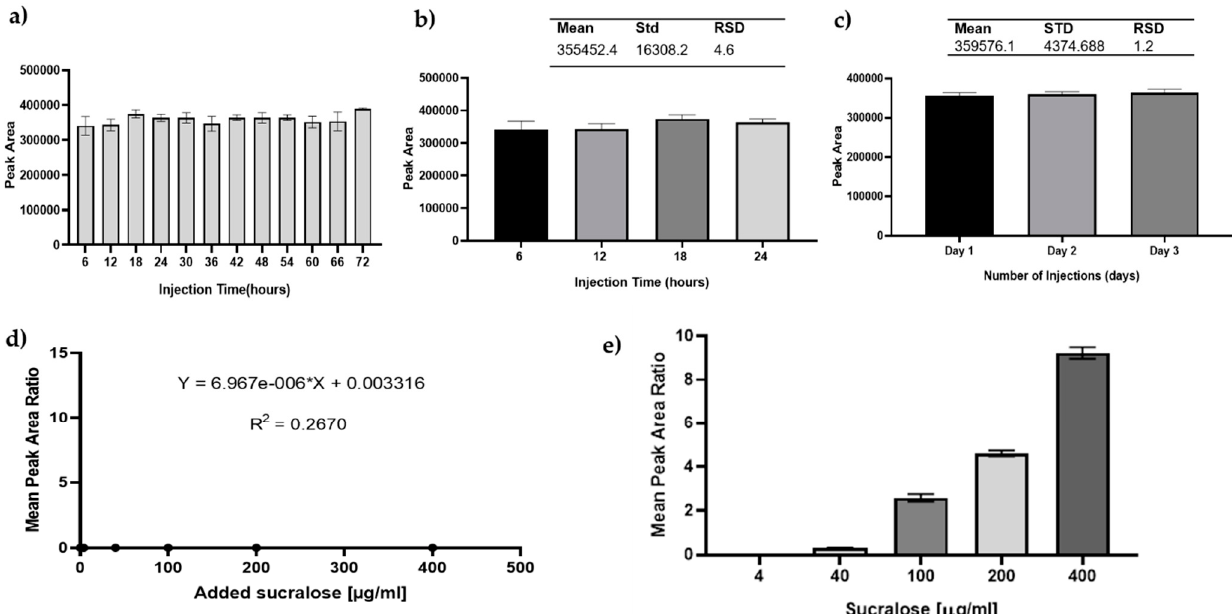
Figure 6. Sucralose was not taken into glomerular endothelial cells. Instrument auto-sampler stability was evaluated as part of the method validation prior cell analysis. Panel ( a ): bar graph of peak area of internal standard (50 µg/mL) plotted against various injection times to determine the autosampler stability of the instrument (GC–MS) and suitability of the internal standard. There was no statistically significant difference between the injections and control using two-way ANOVA. Panel ( b , c ): inter and intra-day precision of sucralose-d6. The intra-day (panel b ) covers data generated over 24 h, while inter-day (panel c ) covers an analysis time of 3 days. The results were analysed using two-way ANOVA and error bars presented as standard deviation with 36 technical repeats. The calculated RSD shown on the top of the bars shows RSD deviation between repeated runs. Results in panels ( d ) and ( e ) indicate that sucralose is not transported across the glomerular endothelial cell membrane. GMVEC were plated and incubated at 37 °C for 24 h, followed by exposure to 500 µL sterile-filtered sucralose concentrations ranging from 4 to 400 µg/mL and then incubated for an additional 24 h. The cell lysate (panel d ) and used media (panel e ) were aliquoted into glass vials, mixed with internal standard, evaporated to dryness, derivatised with MSTFA at 70 °C for 30 min, and analysed using GC–MS. The instrument (GC) conditions were as outlined in the methods section. The mean peak area ratio of the mixed analyte was plotted against sucralose concen- trations. n = 3 of independent experimental repeats.